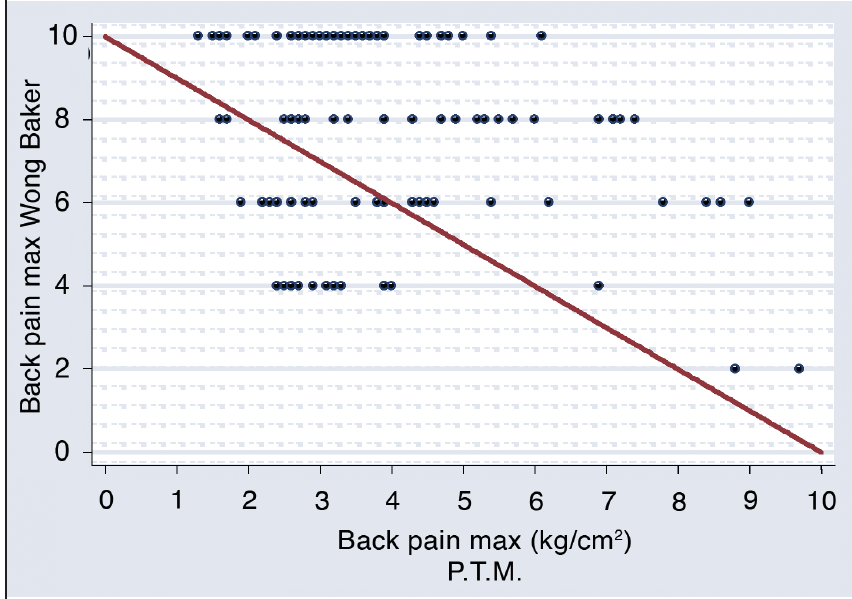
Figure 4: Scatter plot of the maximum pressure pain vs the patient perception on the Wong-Baker Faces pain